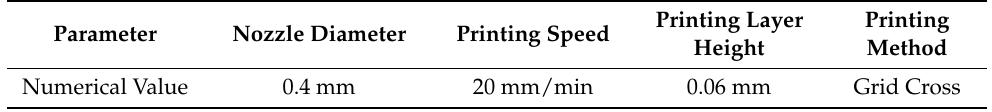
Table 4. Fixed parameters of 3D printing.